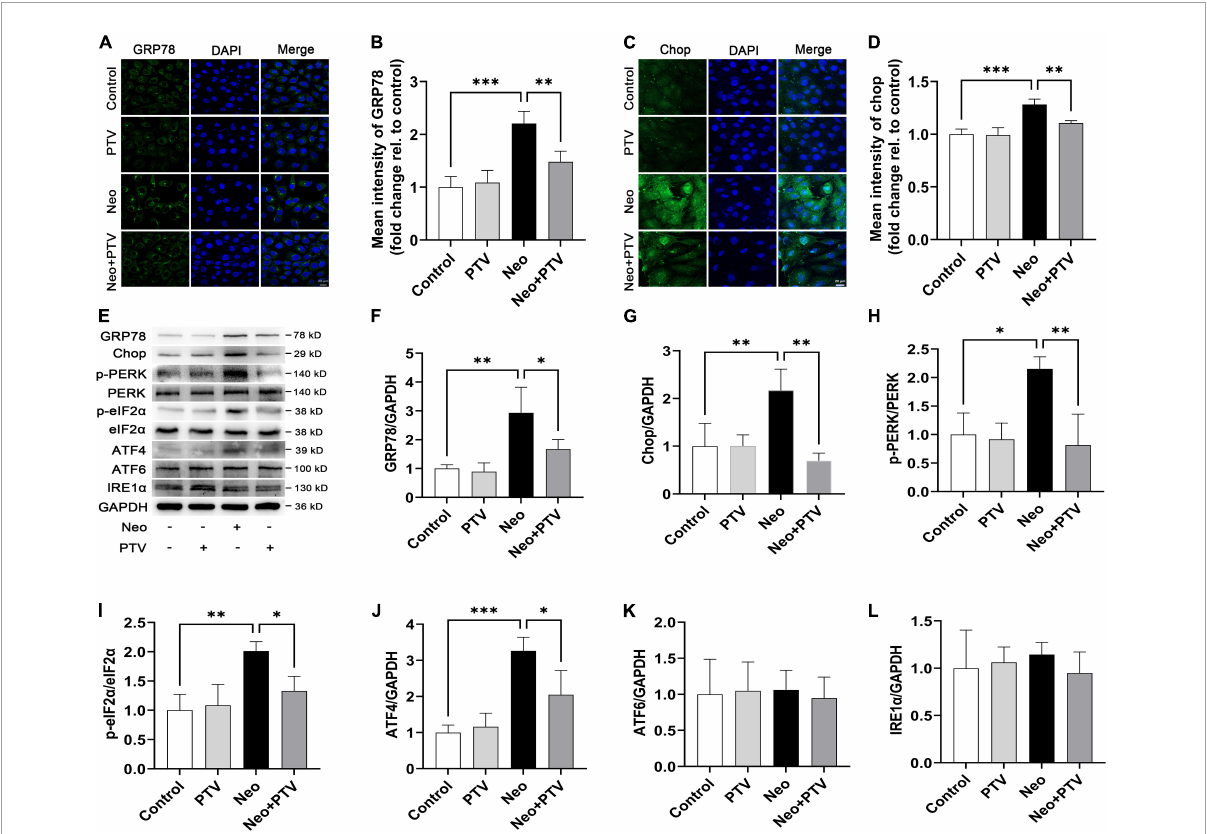
FIGURE6 PTV alleviates neomycin-induced ER stress by inhibiting PERK/eIF2 α /ATF4 signaling. (A,C) Immunofluorescence of HEI-OC1 cells with anti-GRP78 and anti-CHOP antibodies. Scale bars = 20 µ m. (B,D) Statistics of the mean intensity of GRP78 and CHOP in HEI-OC1 cells in (A,C) . (E) Western blot analysis of GRP78, CHOP, p-PERK, PERK, p-eIF2 α , eIF2 α , ATF4, ATF6, IRE1 α , and GAPDH in HEI-OC1 cells with PTV pretreatment followed by neomycin exposure. (F–L) Quantification of the protein expression in (E) with ImageJ ( n = 3). ∗ p < 0.05, ∗∗ p < 0.01, ∗∗∗ p <